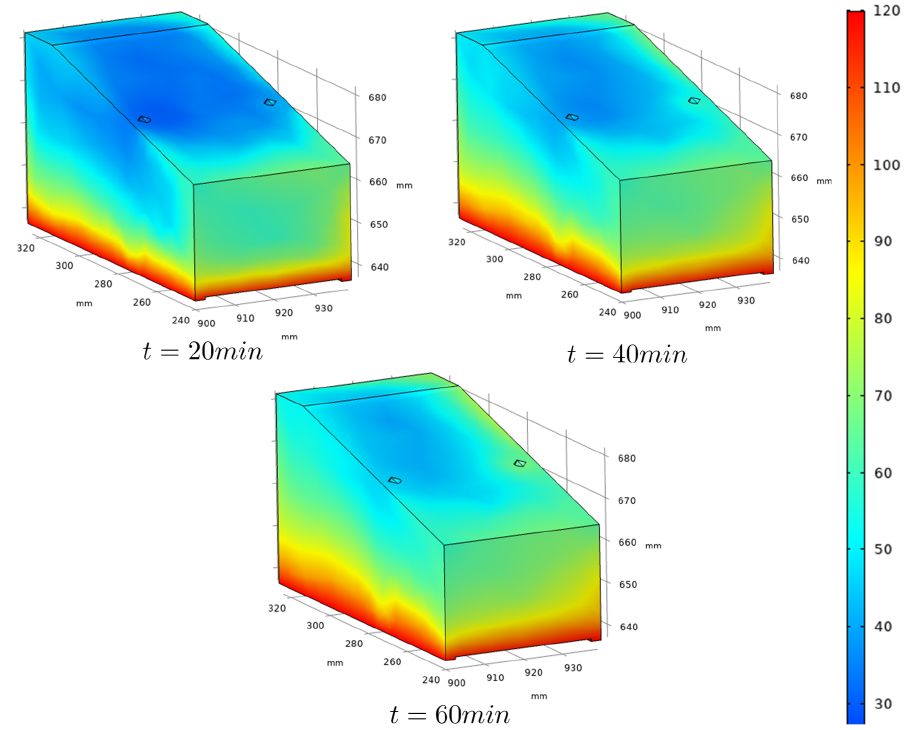
Figure 4. Simulated frames showing the temperature distribution in the outer faces of the wedge for three specific times. The heat propagation to the upper regions of the wedge can be observed.